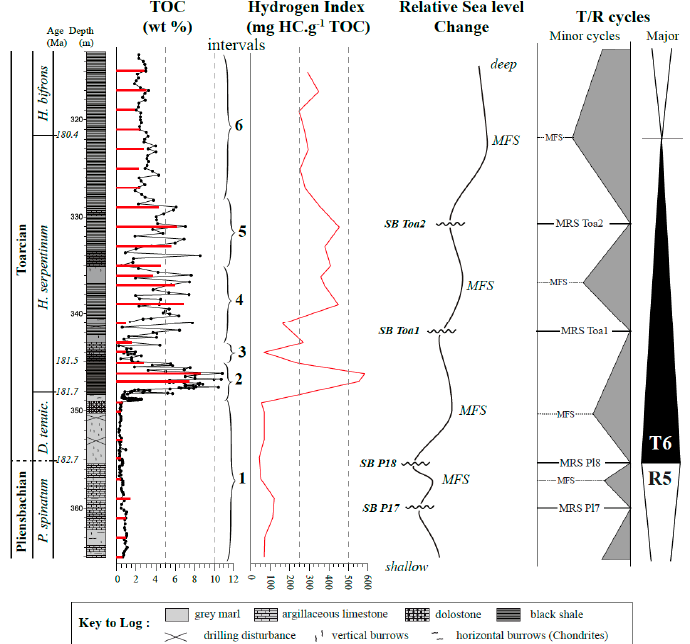
Figure 4. Vertical distribution of TOC and HI of the Lower-Middle Toarcian interval in the Couy-Sancerre core. The red data (TOC and HI) are from this study (black data after Hermoso and Pellenard [33]). The ages are from Ogg and Hinnov [34]. The interval division is linked to the organic content and to the marine vs. terrigenous organic matter ratio.